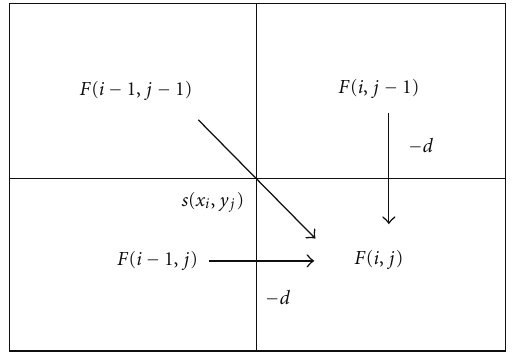
Figure 2: Data dependency of dynamic programming algorithms.